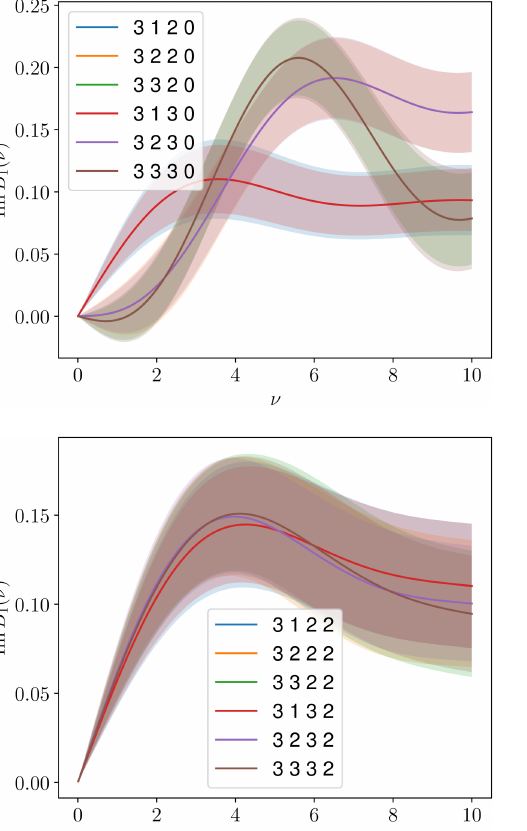
, N , N ) R/I,b R/I,r R/I,p